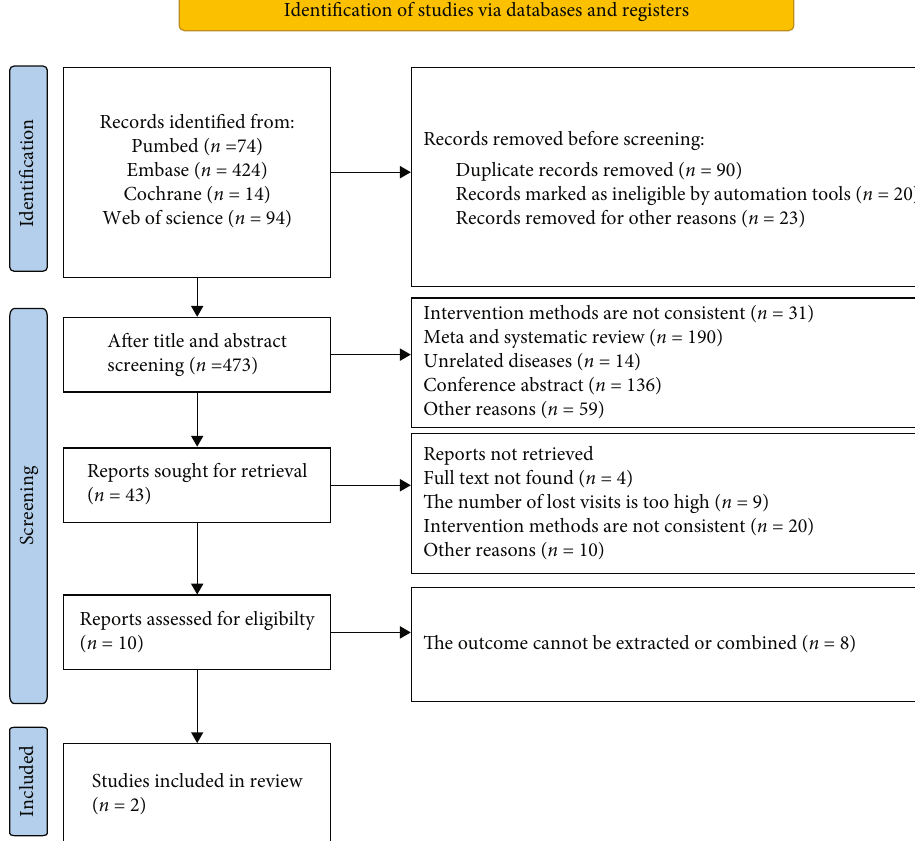
Figure 1: Flow diagram of literature